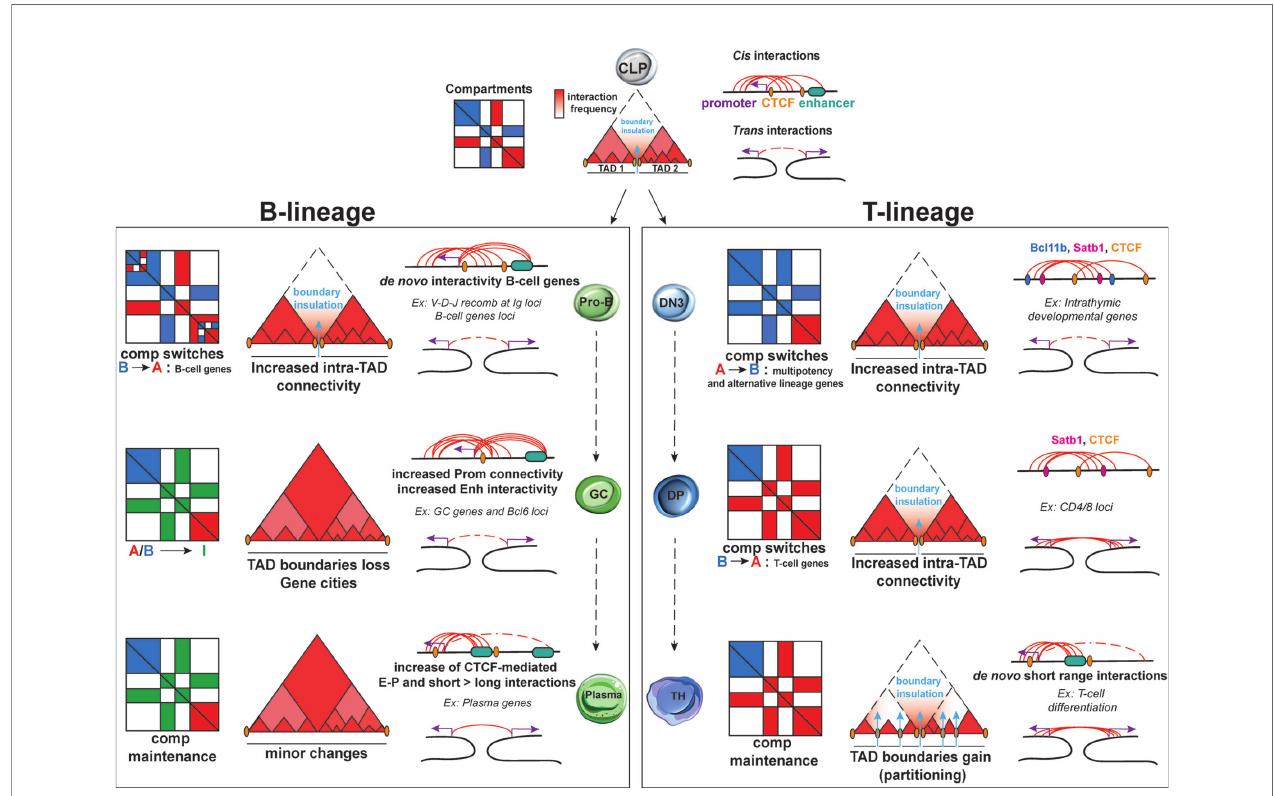
FIGURE 3 | Dynamic 3D chromatin changes during lymphocyte development and differentiation. B lineage: Upon commitment to the B-cell lineage, minor changes are documented for A/B compartments and TADs at the pro-B stage. Nonetheless, major changes in intra-TAD activity are associated with B-cell speci fi c genes. Upon activation, GC B-cells are uniquely characterized by an increase in the weak Intermediate (I) compartments, which are maintained during plasma cells transition. TAD boundaries tend to be lost in GC B cells, leading to “ gene cities ” speci fi c organization. While E-P loops tends to be increased in both GC and plasma cells, the latter subpopulation is characterized by a shift from long to short-range interactions. T lineage: During T lymphocyte development, the earliest global changes in A/B compartment, intra-TAD connectivity and loop formation take place at the T cell commitment step upon the transition of DN2 to DN3 cells but also in the DN4 to SP transition. Conversely, TCR activation does not cause changes in A/B compartments but results in TAD partitioning due to de novo and stronger TAD boundaries. A high proportion of both intra- and interchromosomal interactions are found for these 3 stages of T-cells development and differentiation for which the high E-P loop formation ensures T helper lineage speci fi c gene